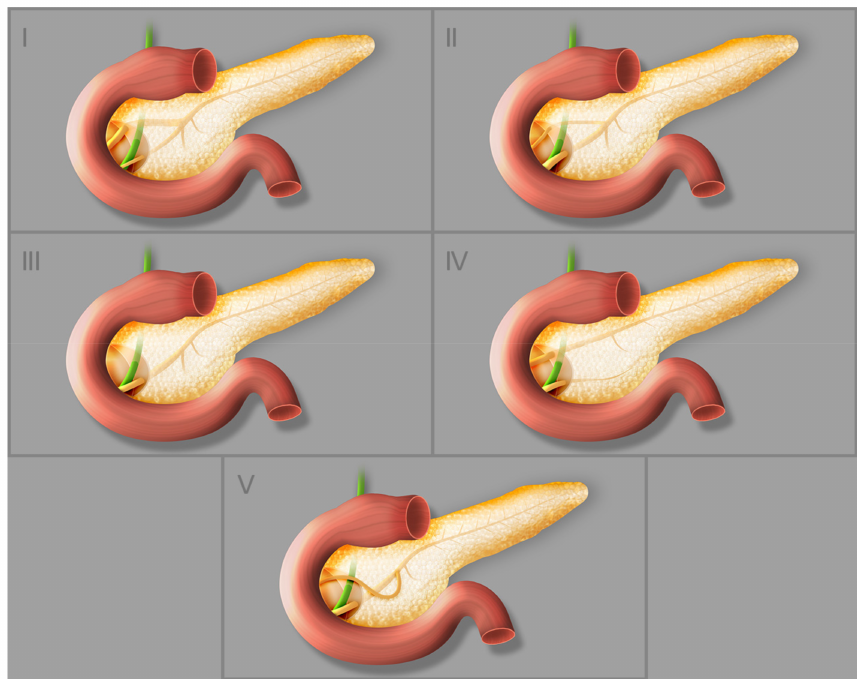
Figure 3. Different types of pancreatic duct configuration: ( I ) bifid configuration with pancreatic duct as the dominant duct, ( II ) bifid configuration with accessory pancreatic duct as the dominant duct, ( III ) rudimentary nondraining or absent accessory pancreatic duct, ( IV ) pancreas divisum, ( V ) ansa